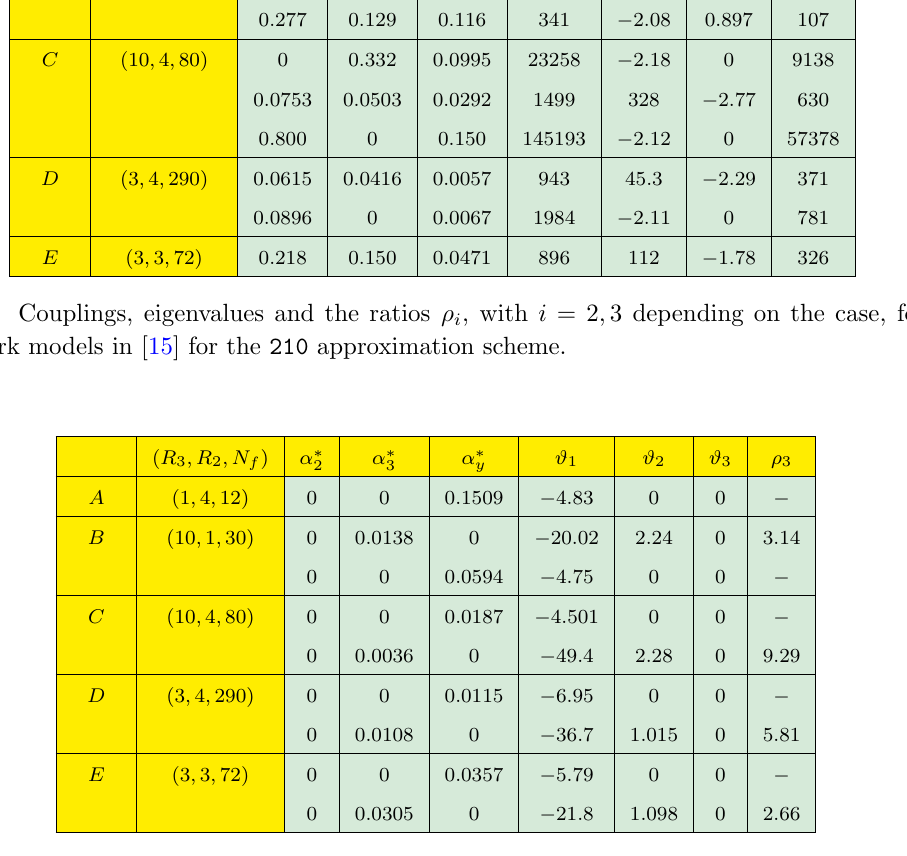
Table 10 . Couplings, eigenvalues and the ratio (cid:26) approximation